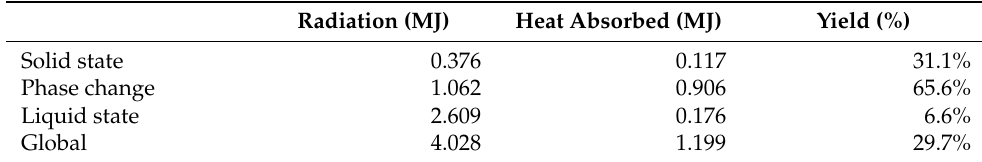
Table 4. Results of the thermal recovery in the different states. Radiation (MJ) Heat Absorbed (MJ) Yield (%) Solid state